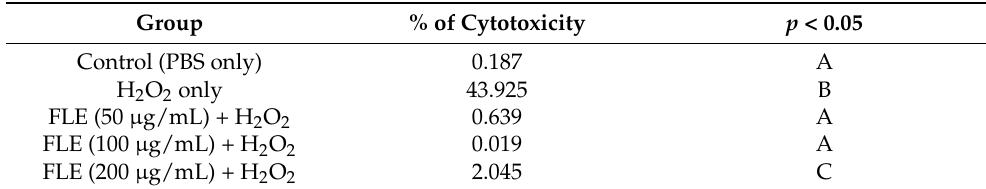
Table 3. Percentage of cytotoxicity in HFFF-3 cells induced with H 2 O 2 after crayfish ( F. limosus ) extract treatment. Control—non-induced cells, treatment only with PBS; H 2 O 2 only—cells induced with H 2 O 2 , treatment only with PBS; Crayfish extract 50–200 ug/mL—induced with H 2 O 2 and treatment with different concentrations of crayfish